Question: Sum up the contents of this chart in one sentence.
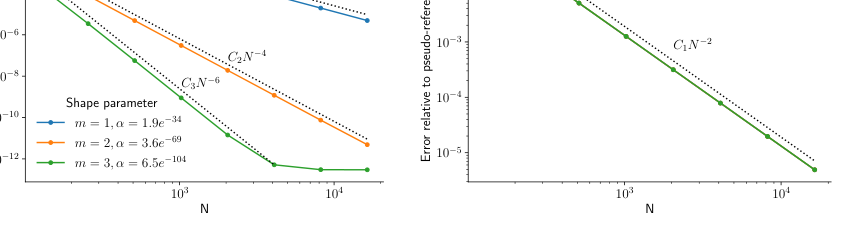
Answer: Left: Relative error as a function of the mesh- size when estimating FY (0.8) where Y = P16 i=1 Xi and Xi ∼ Nakagami-m(m). Right: Relative error as a function of the mesh- size when estimating FY (0.8) where Y = P16 i=1 Xi and Xi ∼ Rice(ν)